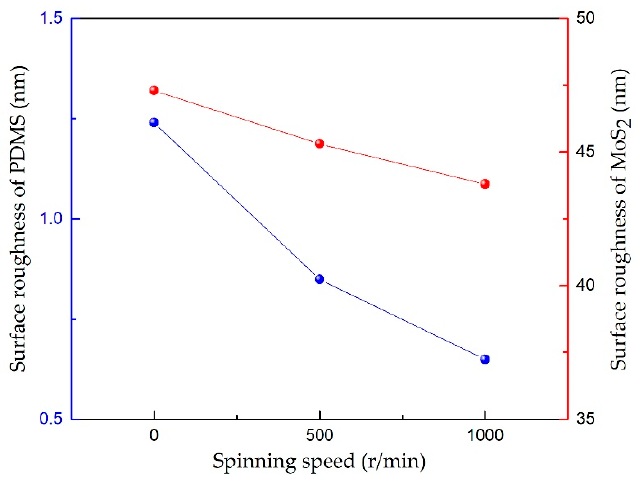
Figure 7. The surface roughness at different spinning speeds.